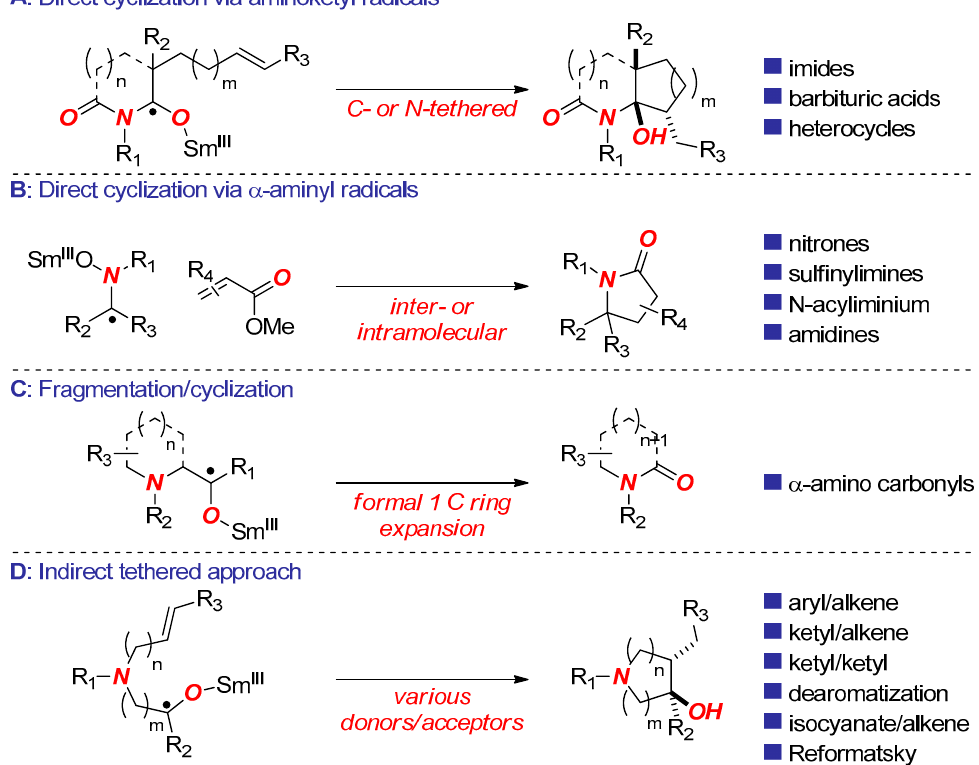
Figure 1. Approaches to the Synthesis of Nitrogen Heterocycles using Samarium(II) Iodide.